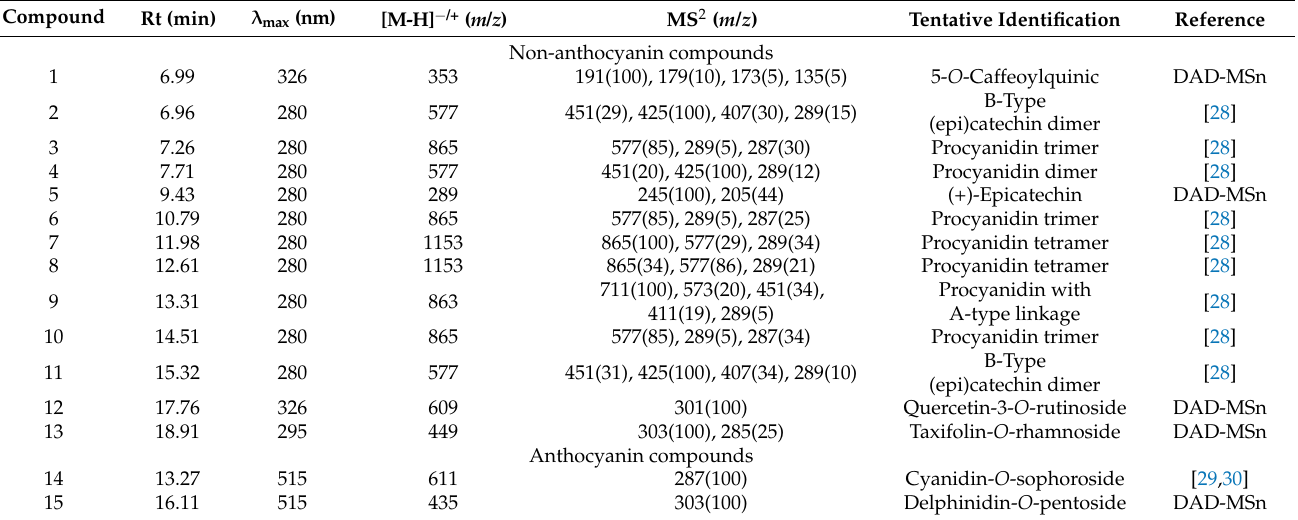
Table 2. Phenolic compounds detected in different extracts of the mangosteen pericarp